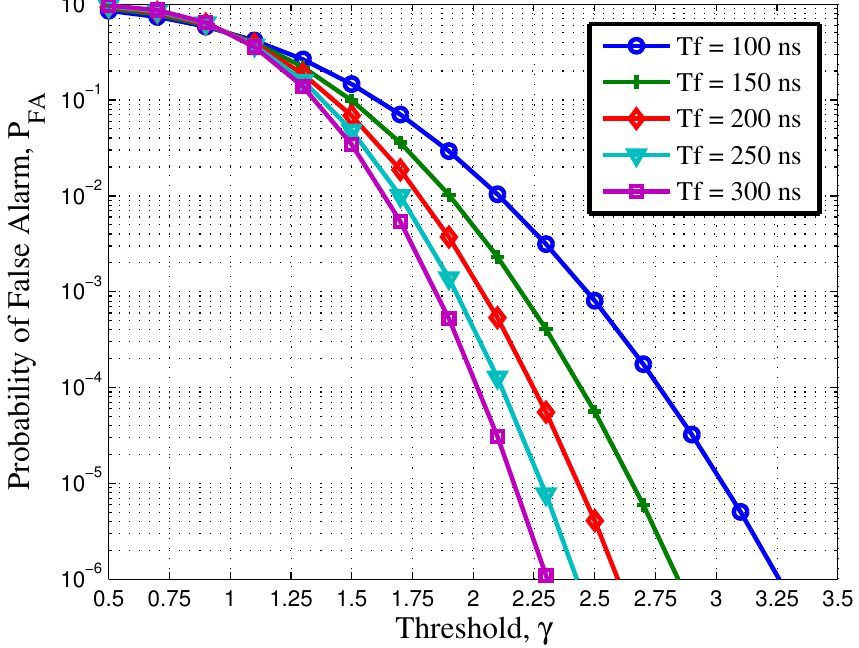
Figure 1. Probability of false alarm versus threshold when using different frame duration at interference noise ratio (INR) = 5